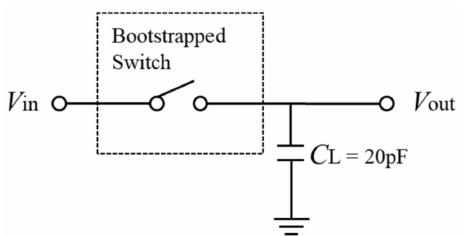
Figure 6. The performance simulation schematic for bootstrapped